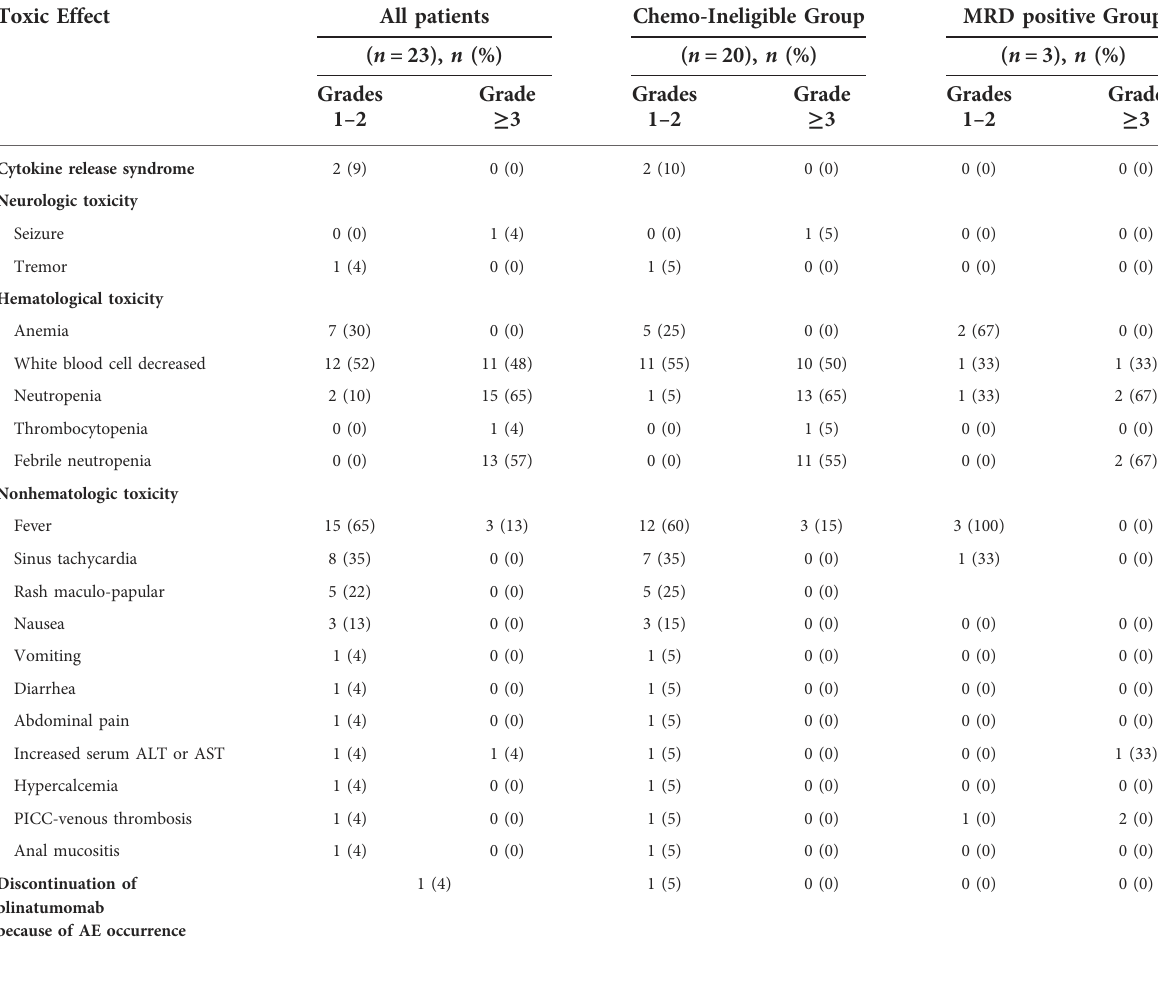
TABLE 3 Adverse events according to CTCAE v